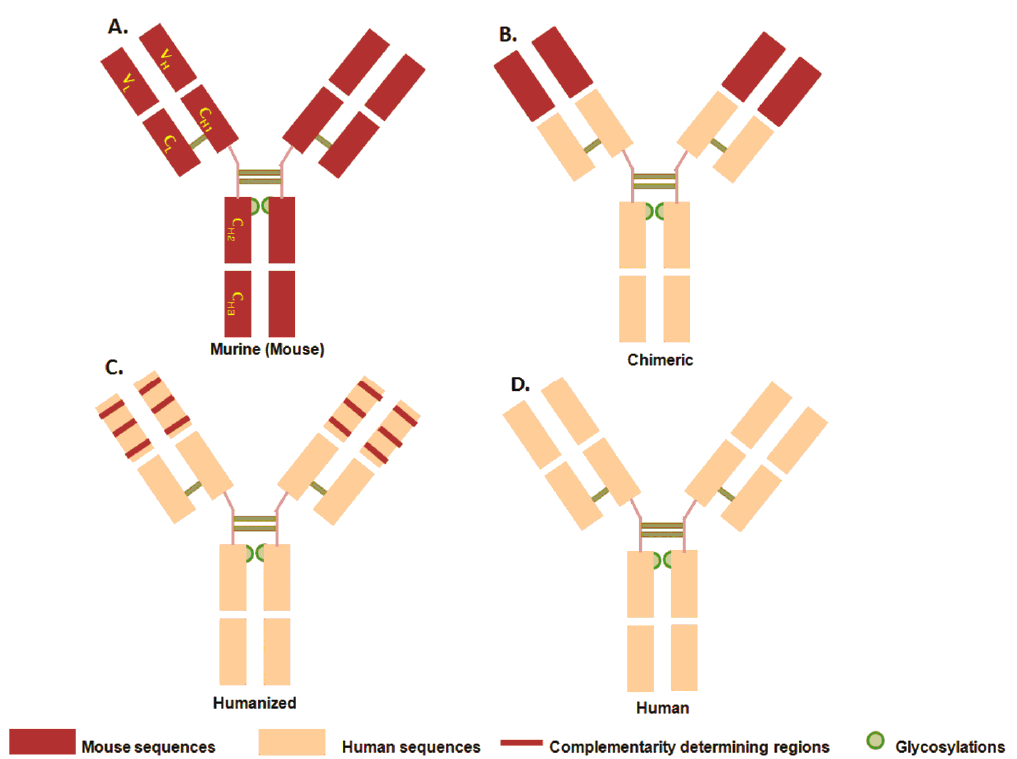
Figure 2. Four generations of Monoclonal Antibodies (mAbs); A : murine; B : Chimeric; C : Humanized and D : Human.